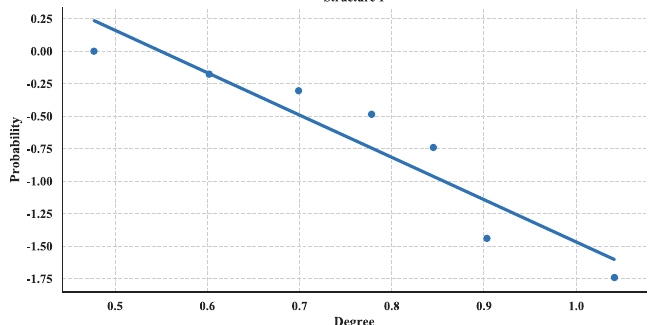
Figure 18. Cumulative Distribution of degree of Structure 1.